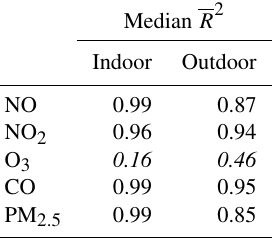
Table 4. Correlations between PAM sensors. Adjusted R 2 values of each sensor pair of the simultaneously carried PAMs were deter- mined. Median R 2 values of all combinations are presented in the table below. Very low O 3 levels ( < 5ppb) resulted in poor between- sensor correlations and are given in